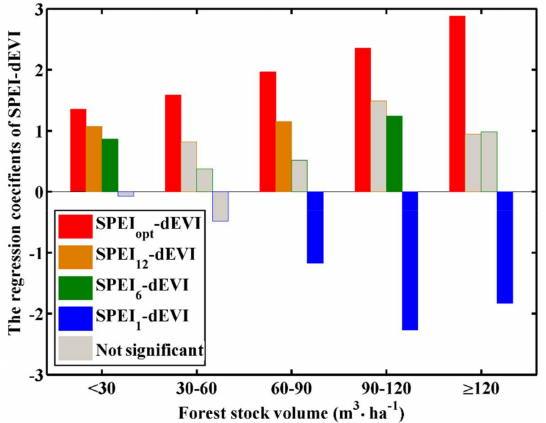
Figure 6. Potential simulation error in SPEI at fixed time scales that ignored the effect of forest stock